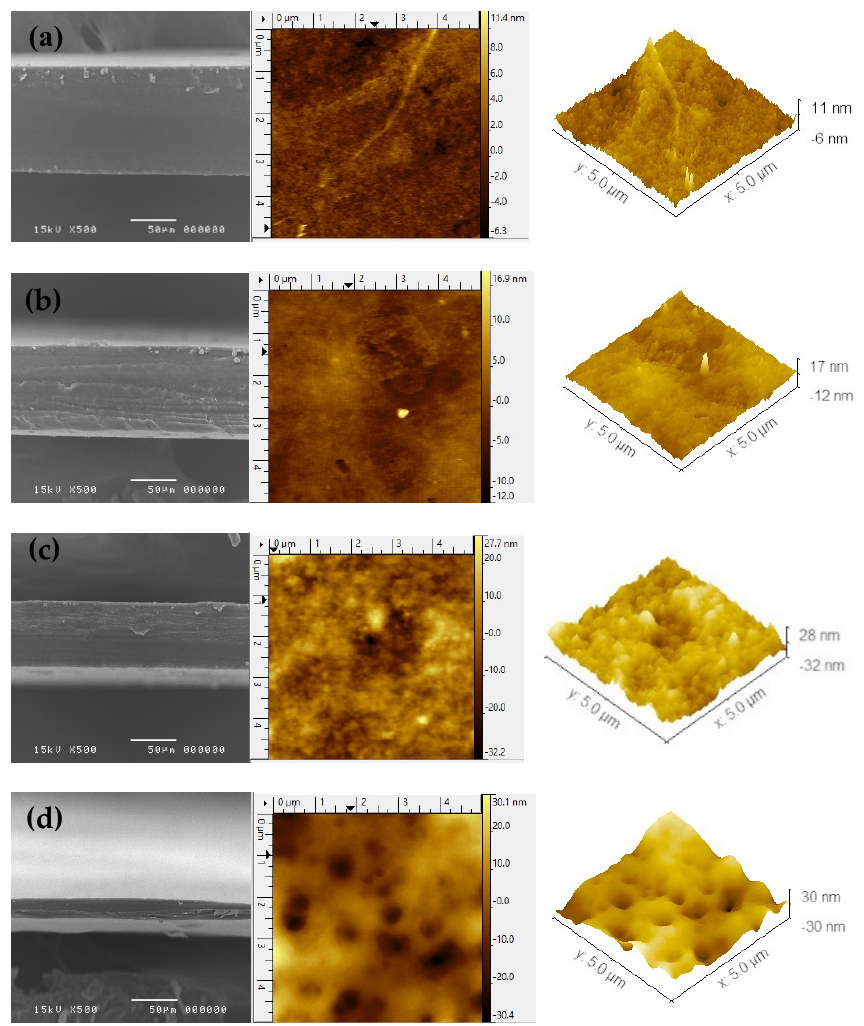
Figure 3. Cross-sectional SEM (left), 2D height AFM topography (middle) and the corresponding 3D AFM topography (right) images of ( a ) E15-20; ( b ) E50-15; ( c ) HMP-15; ( d ) SCMC-5 printed ODFs. Table 3. Atomic force microscopy parameters of 3D-printed